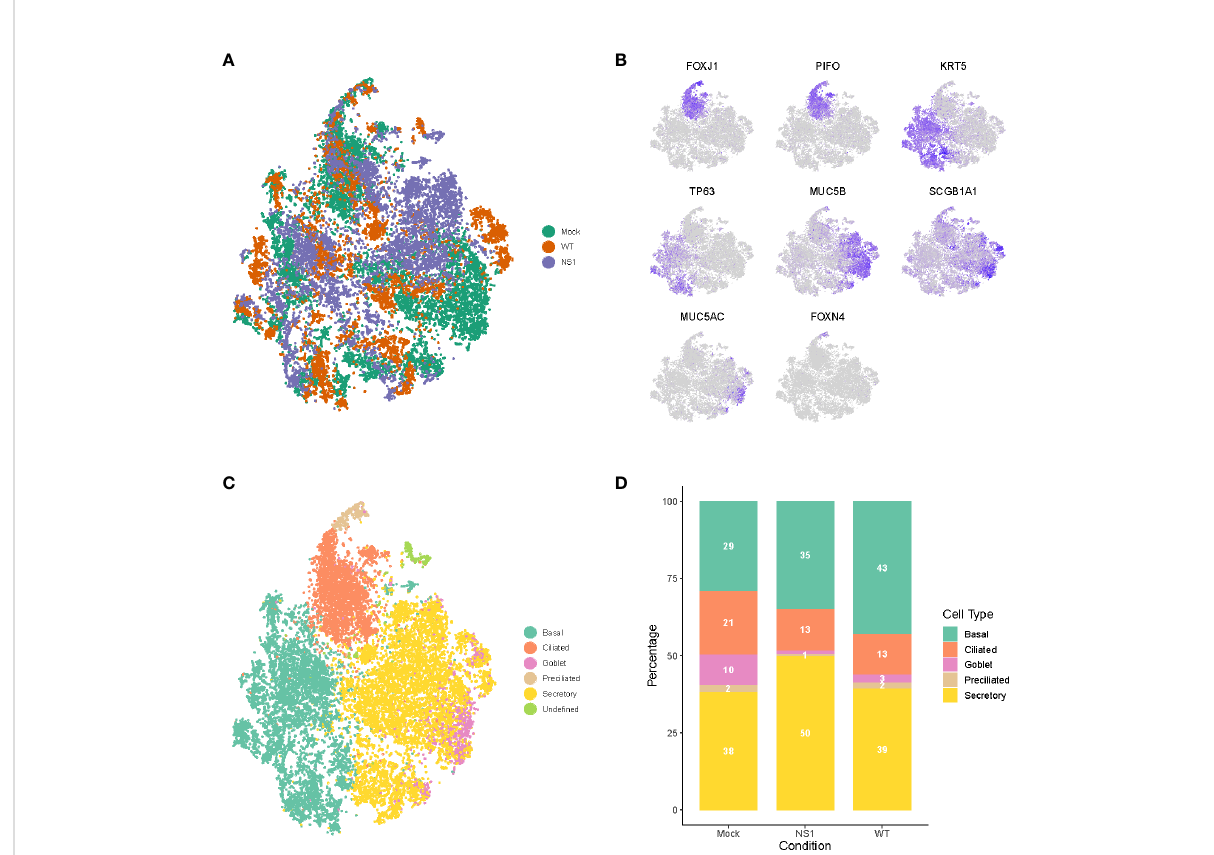
FIGURE 3 Dynamic changes in cellular composition following pandemic IAV infection. (A) t-distributed stochastic neighbor embedding (t-SNE) visualization of the scRNA-seq data for all single cells in the mock (green), WT (orange), and NS1 R38A (purple) conditions following integration of the datasets in Seurat. (B) t-SNE plots illustrating the expression patterns of several canonical airway epithelial cell type-speci fi c markers (purple). (C) t-SNE visualization of the major cell types in primary well-differentiated hAEC cultures. Individual cell types were annotated using a combination of unsupervised graph-based clustering in Seurat and expression analysis of canonical cell type-speci fi c markers. The t-SNE plots shown in (A – C) are presented in the same spatial orientation [i.e. the location of cells expressing the canonical markers in Figure (B) corresponds to the location of the speci fi c cell types in (C) ]. (D) Stacked bar graph showing the relative percentage of each cell type in mock, WT, and NS1 R38A virus-infected hAEC cultures at 18